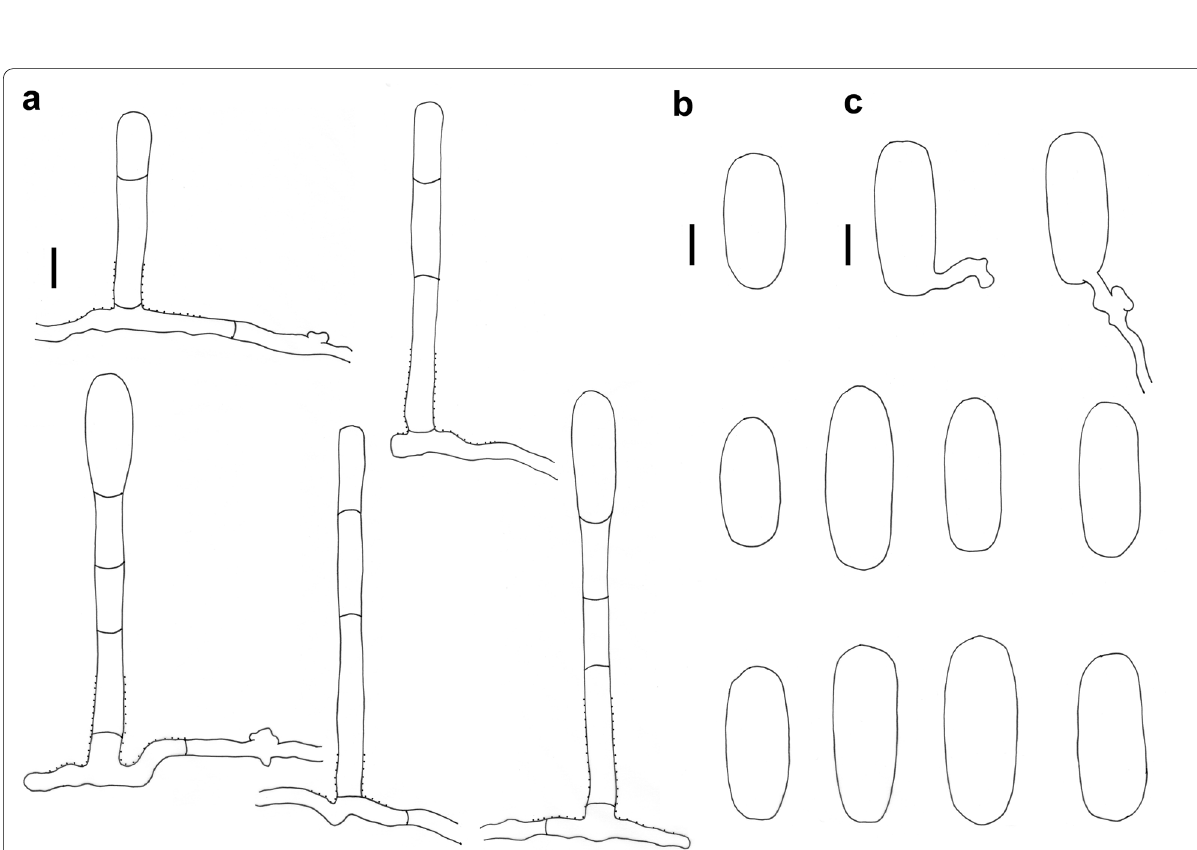
Fig. 4 Erysiphe heraclei on Eryngium foetidum (R. Kirschner 4729). a Hyphae with lobed appressoria and conidiophores. b Conidia. c Conidia with lobed appressoria on germination hyphae. Scale